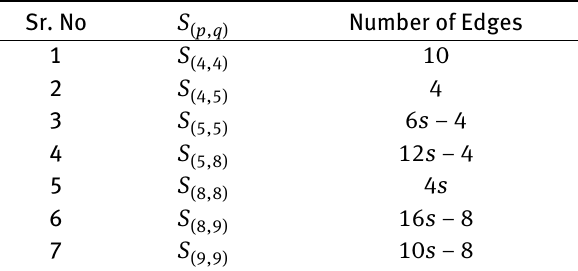
Table 2: The distribution of edges w.r.t. neighbor sum of every vertex the graph of